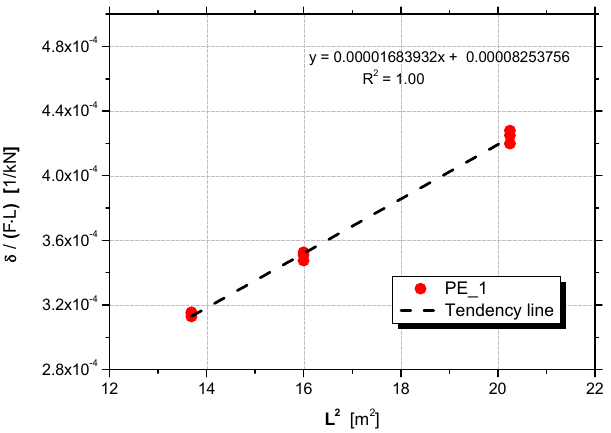
Figure 10. Linear regression of the plot δ / ( F · L ) versus L 2 , for panel PE_1.